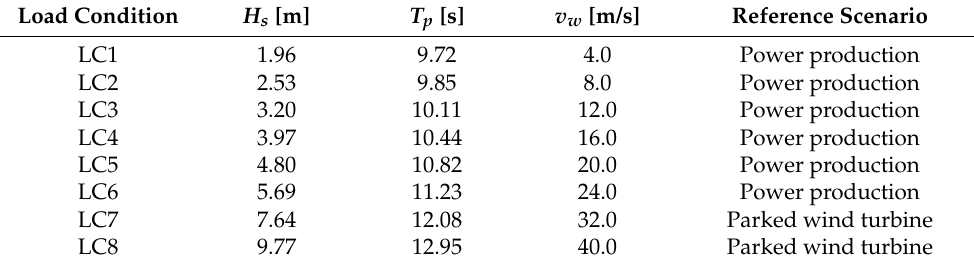
Table 3. Main data of reference